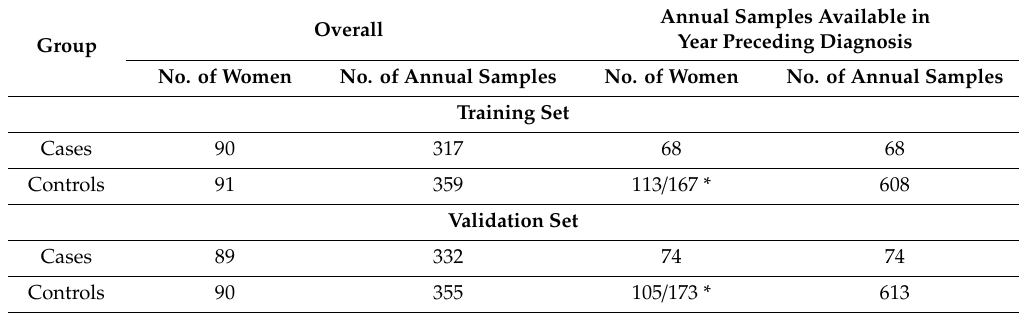
Table 1. Details of cases (invasive tubo-ovarian cancer) and controls in training and validation